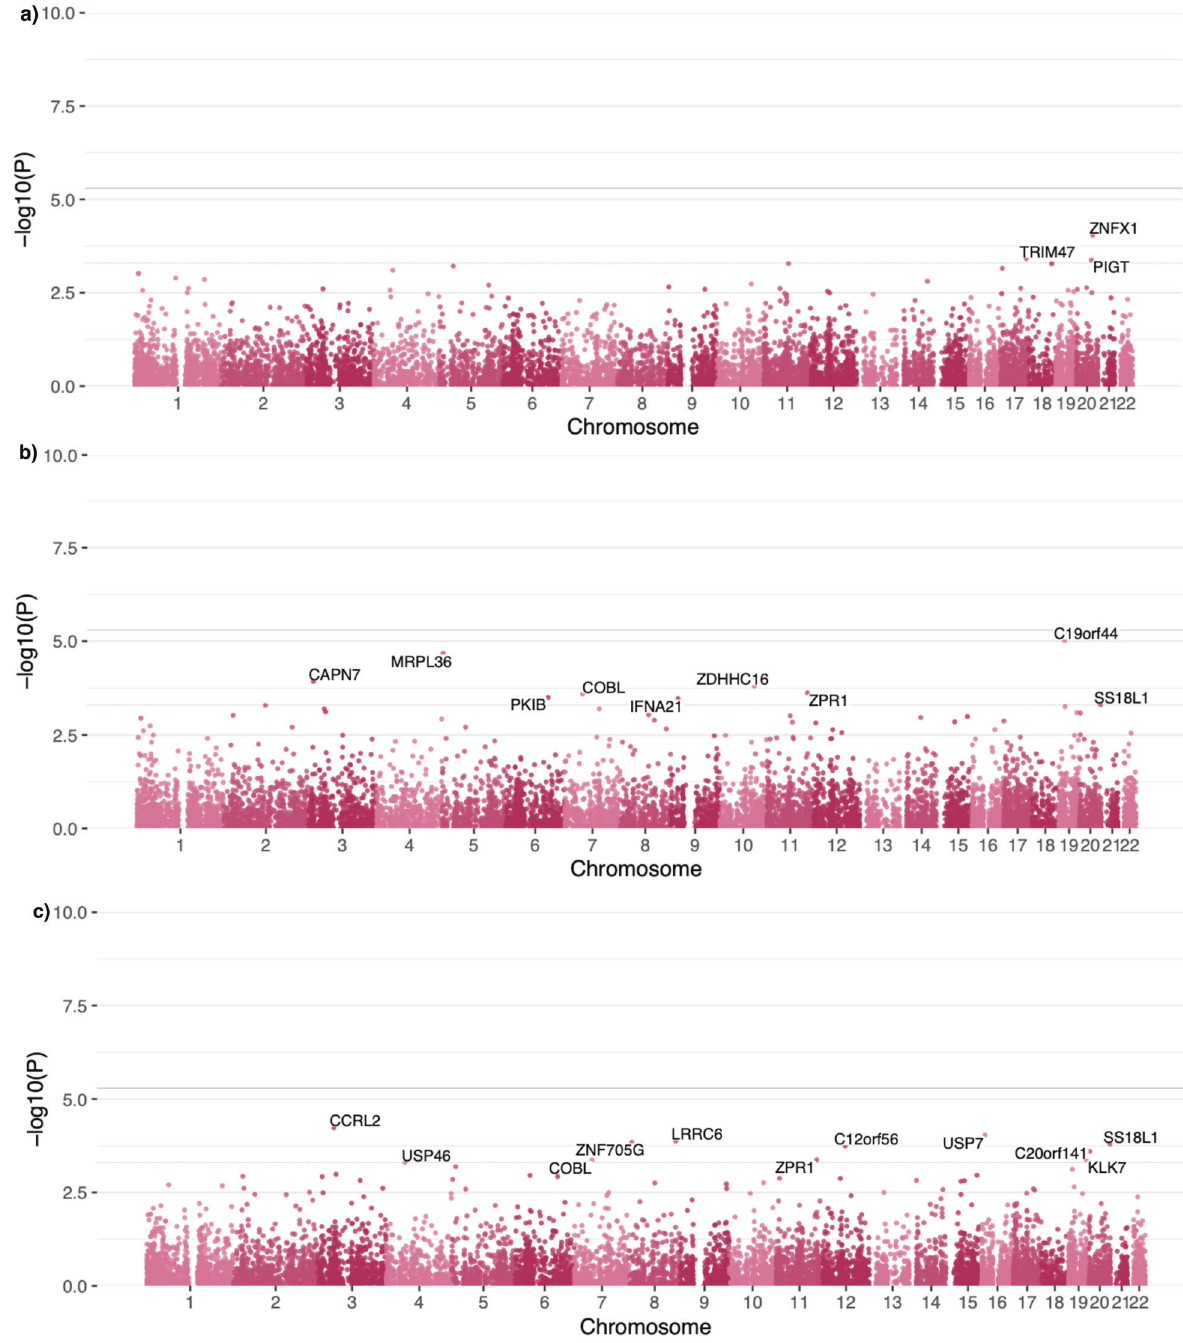
Fig. 3 Manhattan plot for genes. Panels depict the – log 10 (p-value) of association test statistics for genes using gene burden testing with a the internalising factor of depression (Int), b the general factor of schizophrenia (Sch), c the general factor of bipolar disorder (Bip). Points on this plot represent individual genes with predicted deleterious variants. The horizontal axis depicts the genomic coordinate of genes tested for an association with the general factor of schizophrenia. Predicted deleterious variants within the MAF range between 0.05% and 1% were retained for gene burden testing. The solid horizontal line (at p = 4.2 x 10 – 5 ) depicts the threshold for genome-wide statistically signi fi cant associations after Bonferroni correction for number of tests performed. The dashed line (at p < 1 x 10 – 3 ) depicts a more lenient threshold above which genes have been associated with matched disorders (internalising factor with Matched Mendelian disorders . We identi fi ed loci associated with Mendelian disorders with depressive phenotypes, p = 0.81; matched clinical features from Mendelian disorders on OMIM general factor of schizophrenia with Mendelian disorders with (26 loci for depression, 54 loci for schizophrenia and 169 loci for schizophrenia phenotypes, p = 0.08; general factor of bipolar bipolar disorder), as shown in Table 2. Focusing on rare (MAF disorder with Mendelian disorders with bipolar disorder 0.05 – 1%) predicted deleterious variants, there was no enrich- phenotypes, p = 0.28). ment for any of the three sets of common variants previously